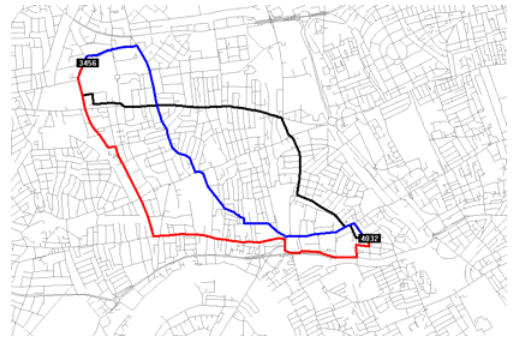
Fig. 6. Efficiency test in Guangzhou network.